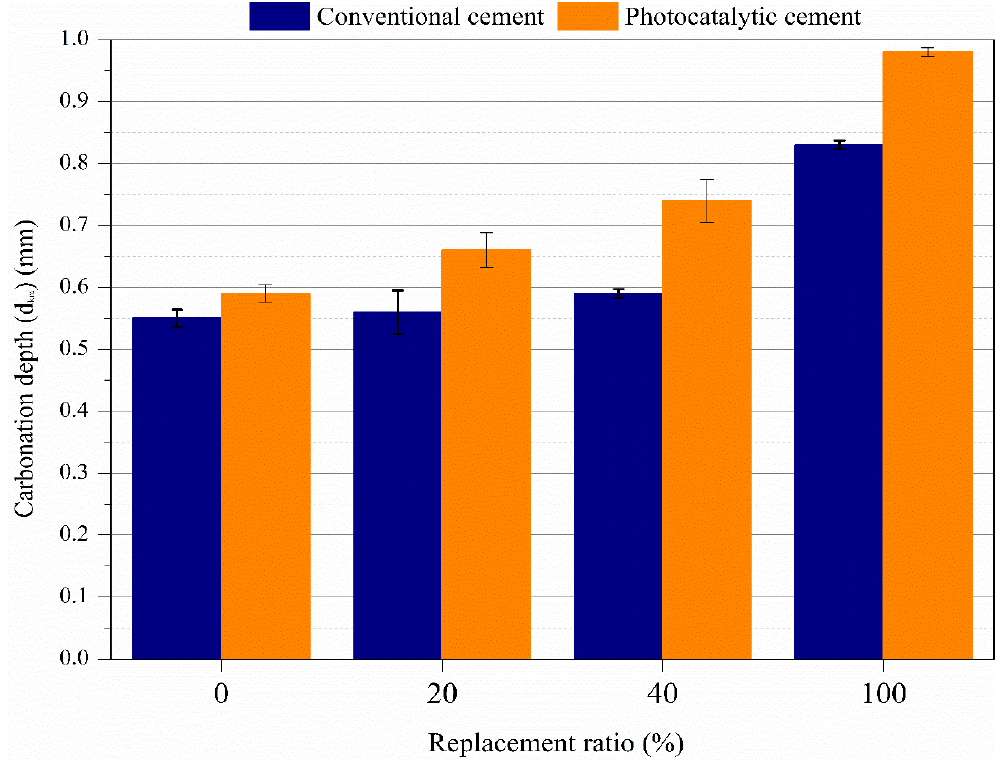
Figure 8. Carbonation depth comparison at 56 days.